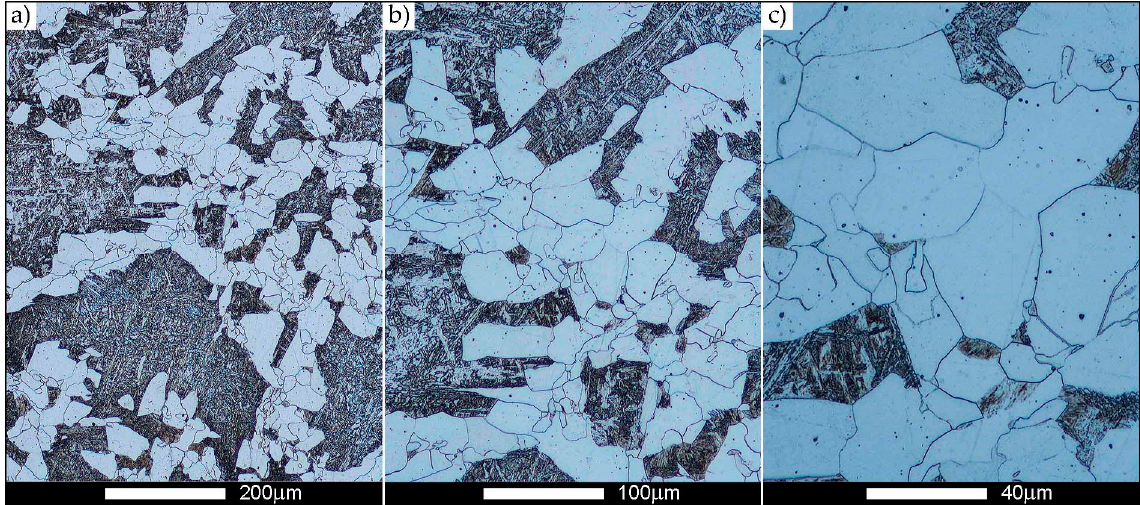
Figure 40. Welded joint microstructure of Hardox 450 steel with visible prior austenite grain boundaries, austenitised at 1100 °C—WM2 zone shown in Figure 2. ( a ) 100×; ( b ) 200×; ( c ) 500×.